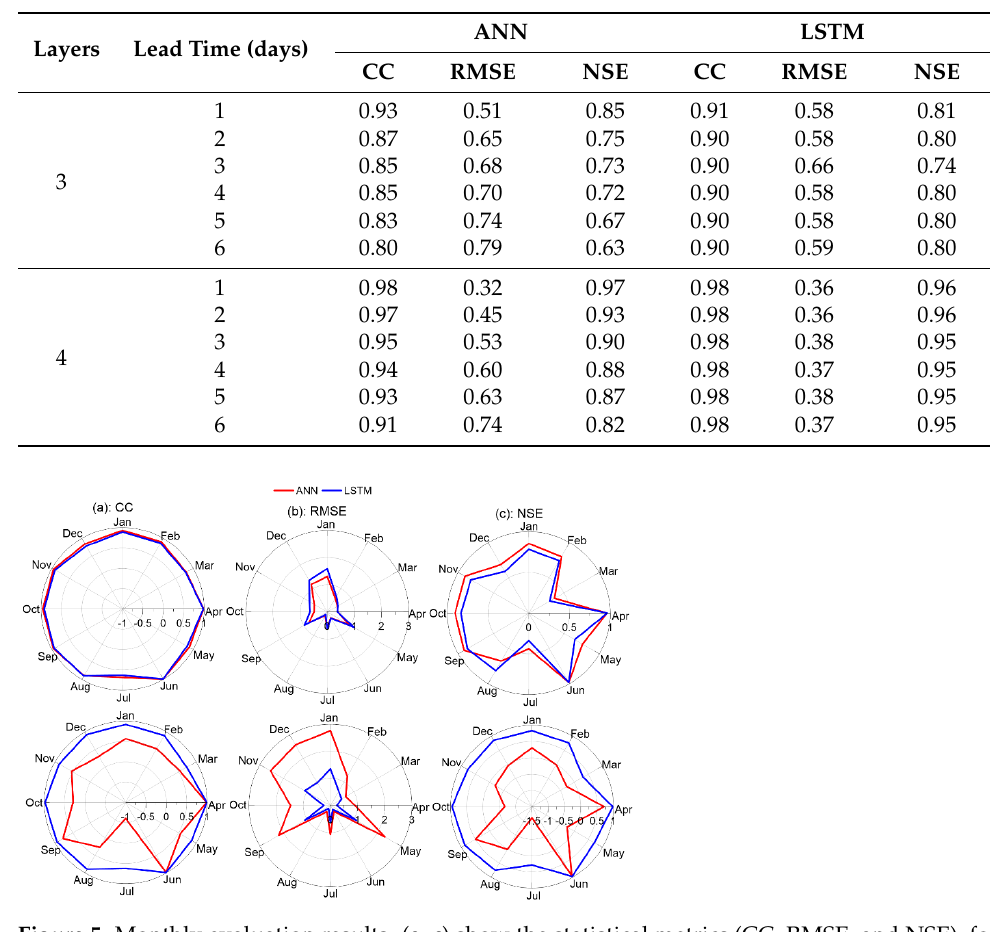
Figure 5. Monthly evaluation results. ( a – c ) show the statistical metrics (CC, RMSE, and NSE). for layer 1. The first and second lows represent monthly evaluation results for lead times of 1 and 6 days of lead times.